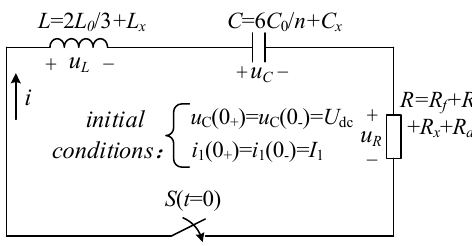
Figure 5. Equivalent discharge circuit of main converter capacitor.